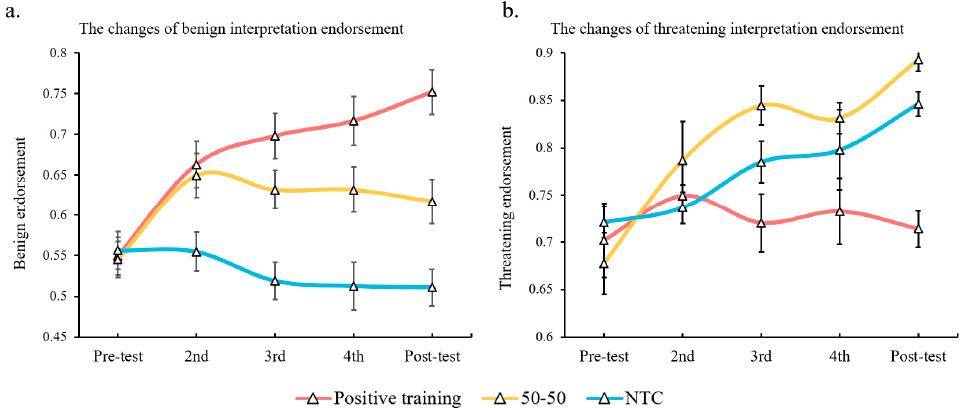
Figure 4. Changes of benign ( a ) and threatening ( b ) interpretation endorsements for three groups during the experiment.